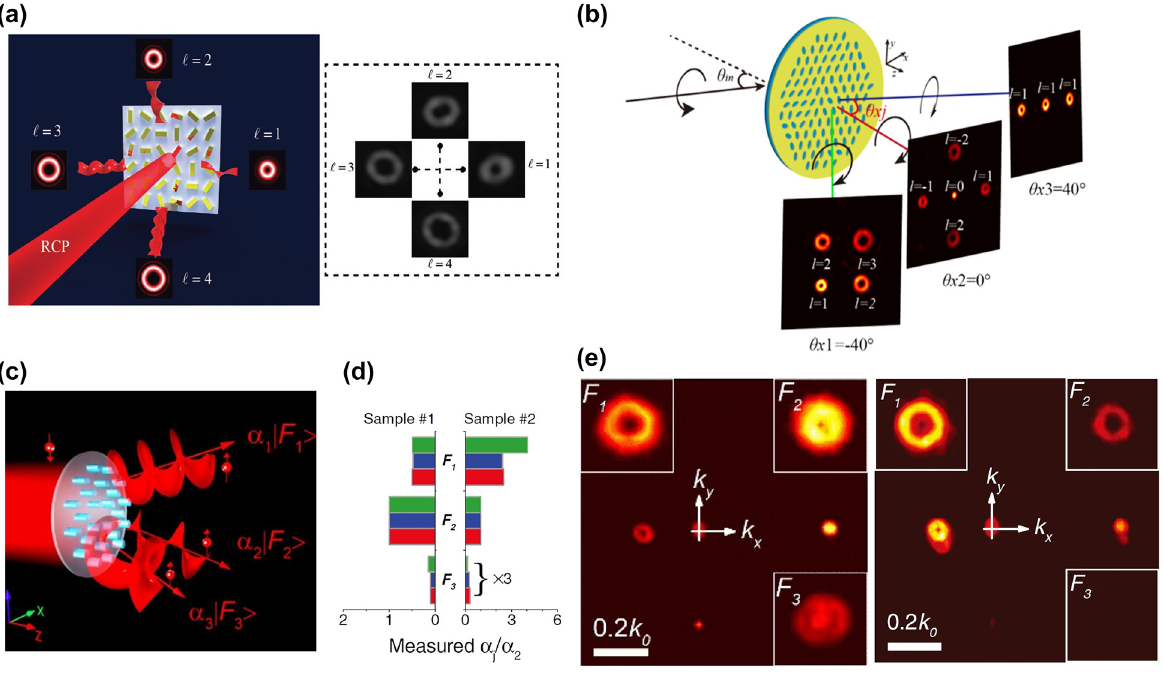
Figure 5: Metasurface for OV multiplexing. (a) Left: Schematic of off-axis multi-OAM generation. Right: Measured intensity profiles of four OAM beams with topological charges ranging from l = 1 to 4 generated under the illumination of an RCP light [80]. (b) Schematicof angle multiplexed multichannel OV generation based on the PB phased based metasurface. The light with different colours depicts different de fl ection angles. θ in is the angle of incidence, while θ xi ( i = 1, 2, and 3) is the de fl ection angle of an outgoing light [81]. (c) Schematicof the energytailorable multifunctional metasurface [82]. (d) The designed,calculated, and measured energiesof each functionality of designedsamples [82]. (e) The measured light intensity distributions of fabricated samples in k -space